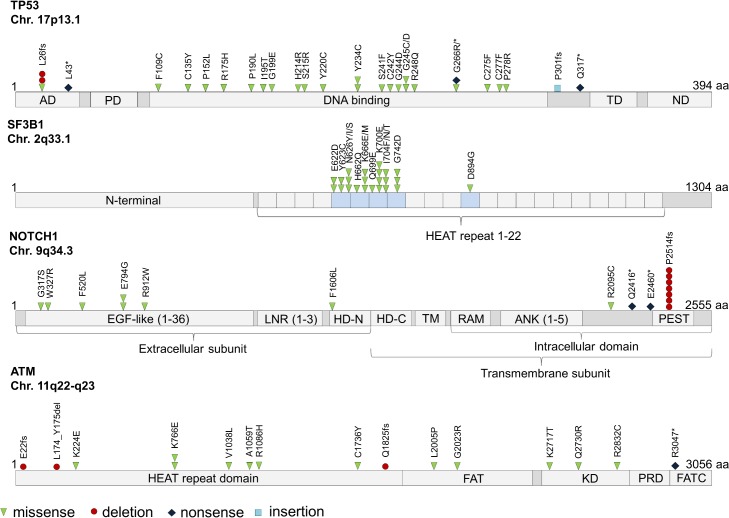
Alteration type, number of occurrence and location of detected mutations in TP53, SF3B1, NOTCH1 and ATM are shown.
TP53: AD activation domain (amino acid 1–50); PD proline-rich domain (amino acid 63–97); TD tetramerization domain (amino acid 323–356); ND negative regulation domain (amino acid 363–393); SF3B1: The majority of SF3B1 alterations were clustered in the region encoding the highly conserved HEAT (huntingtin, elongation factor 3, protein phosphatase 2A, target of rapamycin 1) repeats 5–8. Only one alteration occurred in the N-terminal (amino acids 1–450), domain, which is an important docking or binding domain for numerous splicing factor partners like U2AF1/2, and cyclin E. NOTCH1: (EGF)-like epidermal growth factor repeats (amino acid 20–1426), LNR Lin-12 NOTCH repeats (amino acid 1449–1571), HD-N/C heterodimerization domain (N-terminus; C-terminus), RAM RAM domain, ANK ankyrin repeat domain (amino acid 1927–2089); PEST Pro-Glu-Ser-Thr motif for degradation (amino acid 2507–2526); ATM: FAT FRAP-ATM-TRRAP (amino acid 1960–2566), KD protein kinase domain (amino acid 2712–2962), PRD PIKK-regulatory domain (amino acid 2961–3025), FATC FAT-c-term domain (amino acid 3024–3056); aa amino acid